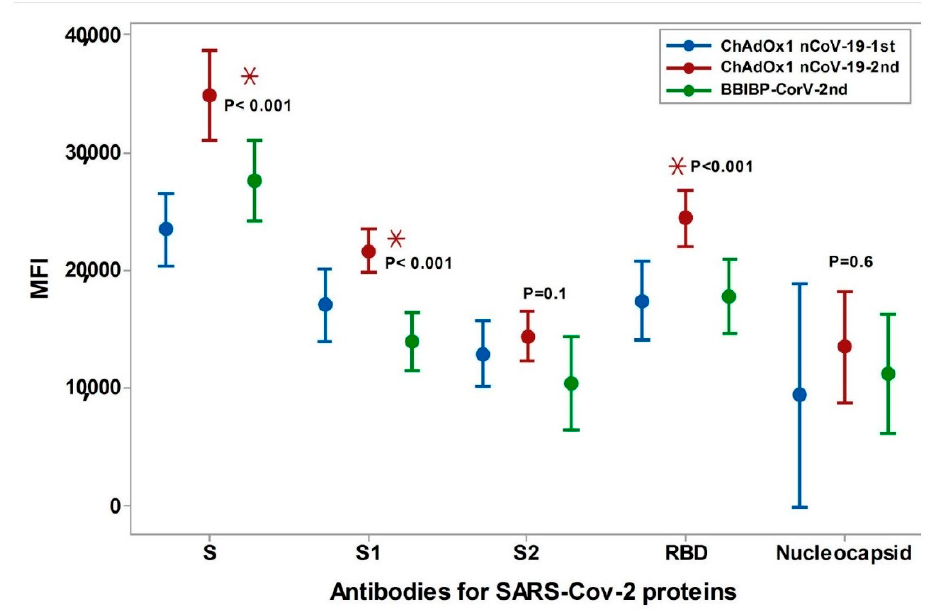
Figure 3. Comparison of the different antibody levels after the first dose of ChAdOx1 nCoV-1 vaccine, second dose of ChAdOx1 nCoV-1, and after the second dose of BBIBP-CorV vaccine. ChAdOx1 nCoV-19 1st: the first dose of ChAdOx1 nCoV-19 vaccine, ChAdOx1 nCoV-19 2nd: The second dose of ChAdOx1 nCoV-19 vaccine, BBIBP-CorV2nd: The second dose of BBIBP-CorV vaccine, MFI: Mean Fluorescent Intensity. Cutoff of MFI for Anti-Spike was 7500, Anti-Spike S1 was 4000, Anti-Spike RBD was 3500, Anti-Spike S2 was 1900, Anti-nucleocapsid was 3500. * Represents the Statistically significant values.